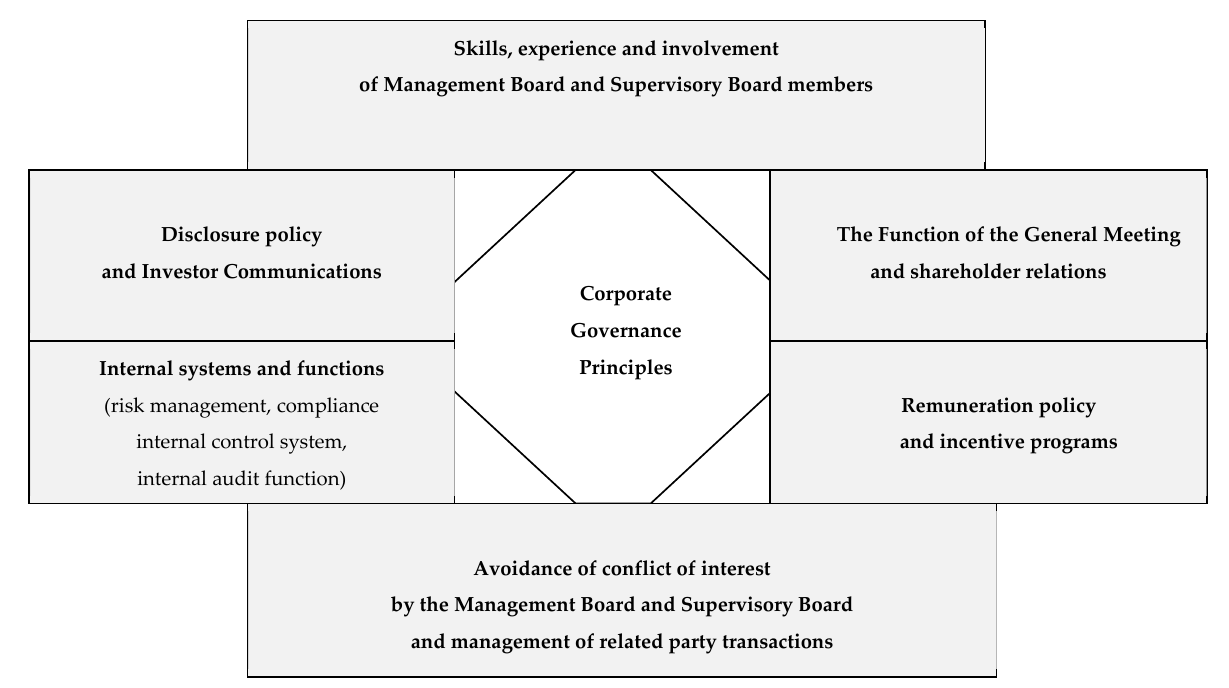
Figure 4. Author’s recommendations for energy companies listed on the Polish stock exchange in the area of reporting CG information. Source: the authors.